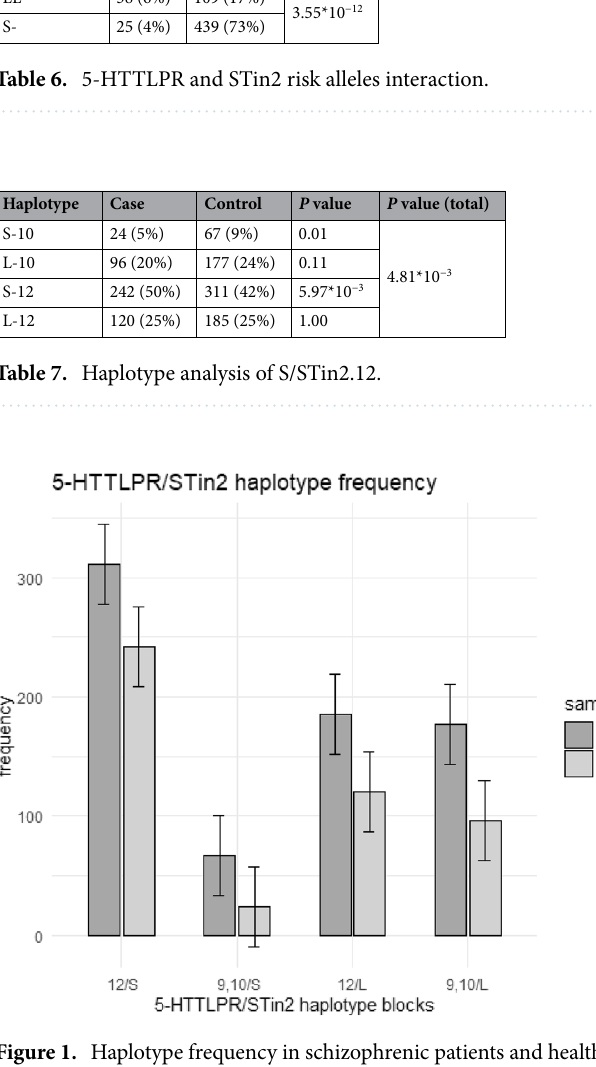
Figure 1. Haplotype frequency in schizophrenic patients and healthy